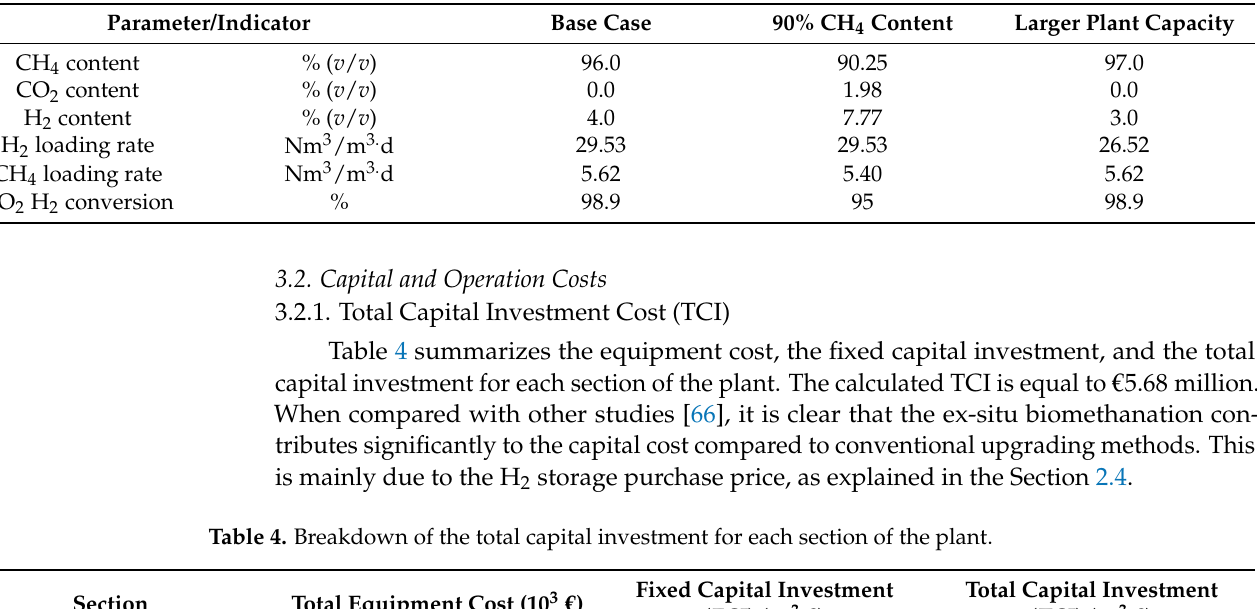
Table 3. Biomethanation results indicators.